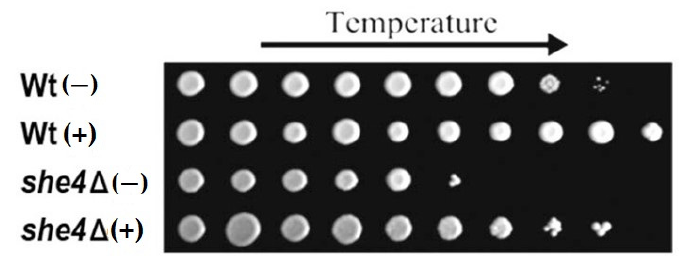
Figure 2. Wild type (Wt) and she4 Δ S. cerevisiae cells pinned on 2% ( w / v ) peptone, 1% yeast extract, 2% glucose (YPD), 1.5% agar, and grown 2 days at 30 °C immediately following a prior 48 h growth on liquid YPD either without ( − ) or with (+) 1.2M sorbitol as osmotic stabiliser, this 48h growth having been conducted under 1.25 °C increases in temperature (left to right 30, 31.25, 32.5, 33.75, 35, 36.25, 37.5, 38.75. 40 and 41.25 °C).